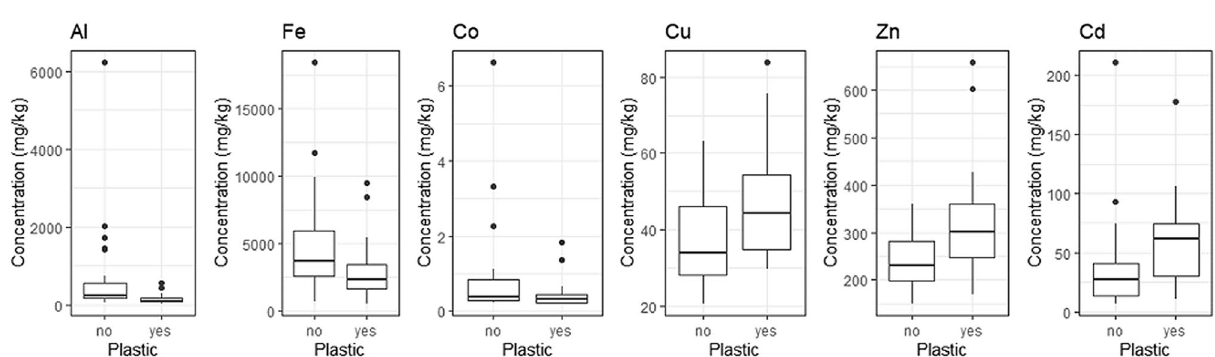
Figure 4. Liver concentration of Al, Fe, Co, Cu, Zn and Cd (mg/kg of dry mass) in pooled prions (n = 50), including both fairy (n = 25) and slender-billed prions (n = 25) that had not ingested (n = 30, left bars) or ingested (n = 20, right bars) plastic at the time of death in emaciated condition during a “seabird wreck” in New Zealand, August